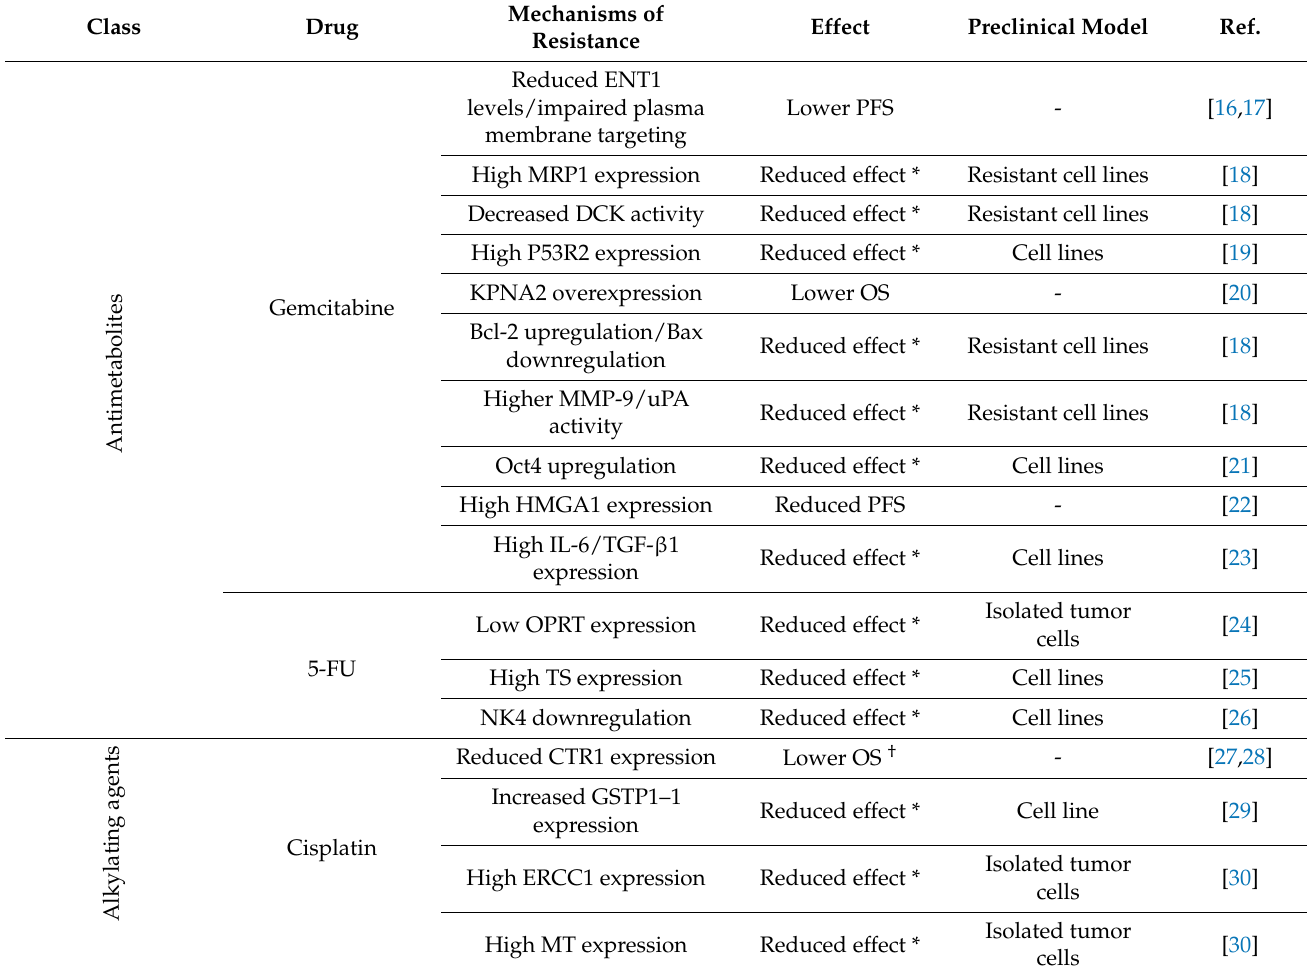
Table 1. MPRs to classical chemotherapy in